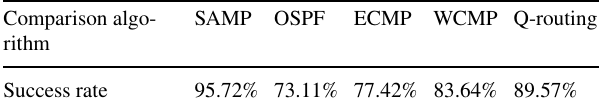
Table 2 Transmission success rate in static network load Comparison algo- rithm